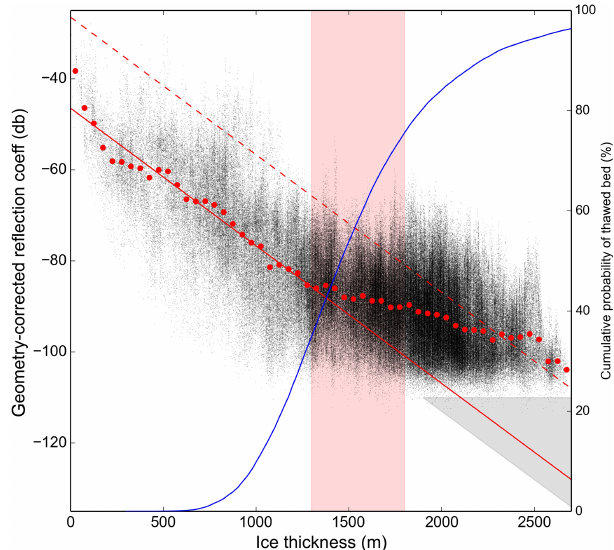
Figure 5. Geometry-corrected reflection coefficients vs. ice thick- ness for all bed picks in the survey. Red dots show the median reflection coefficient for 50m wide ice thickness bins that were used in calculating the slope. The solid red line shows the slope for − 15 . 1dBkm − 1 (one-way) based on calculations for ice thicknesses less than 1300m. The red rectangle shows the region where we as- sume that increased presence of water at the bed causes a broad- ening of the reflection coefficient distribution, and the gray triangle indicates the region where the signal-to-noise ratio could explain the absence of data. The dotted line has been shifted up 20dB from the shallow-ice fit, representing the higher reflection coefficients ex- pected if there is water at the bed. The blue line shows the cumula- tive probability of a thawed bed for a given ice